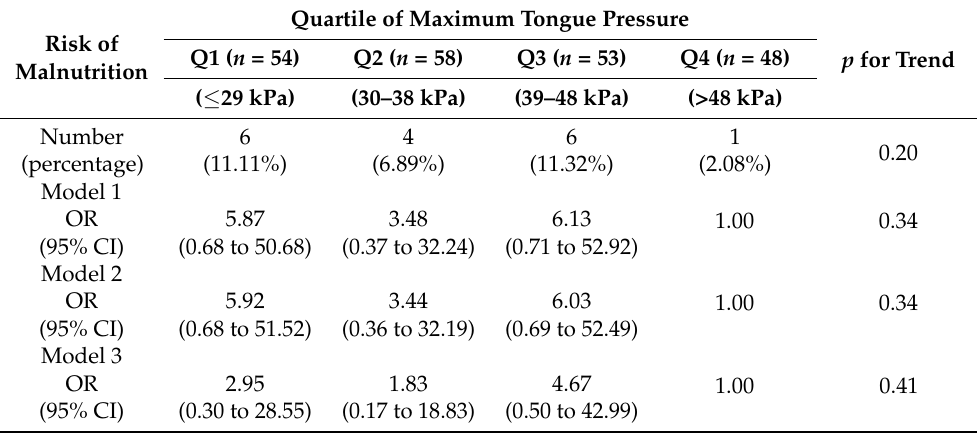
Table 3. The association of risk of malnutrition with different quartiles of tongue pressure in the female participants. Risk of